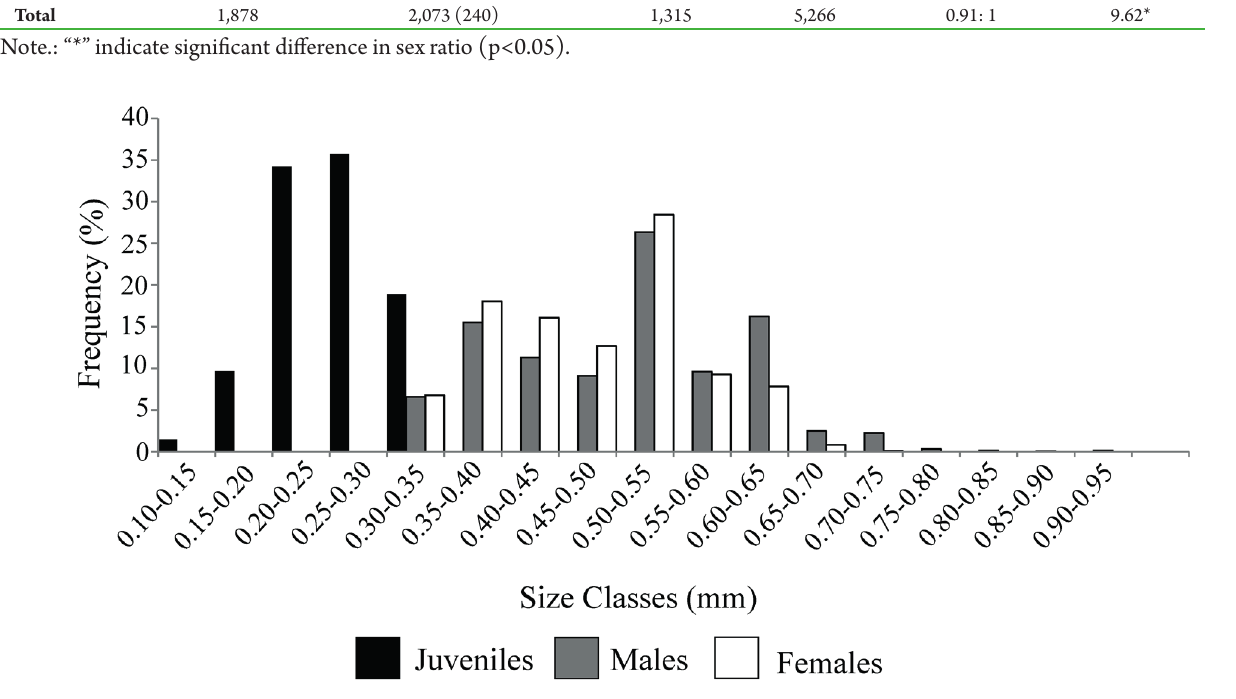
Figure 1. Frequency distribution in size classes of cephalothorax length (CL in mm) for males and females from a population of Hyalella bonariensis of Silveira Martins, state of Rio Grande do Sul, Brazil.